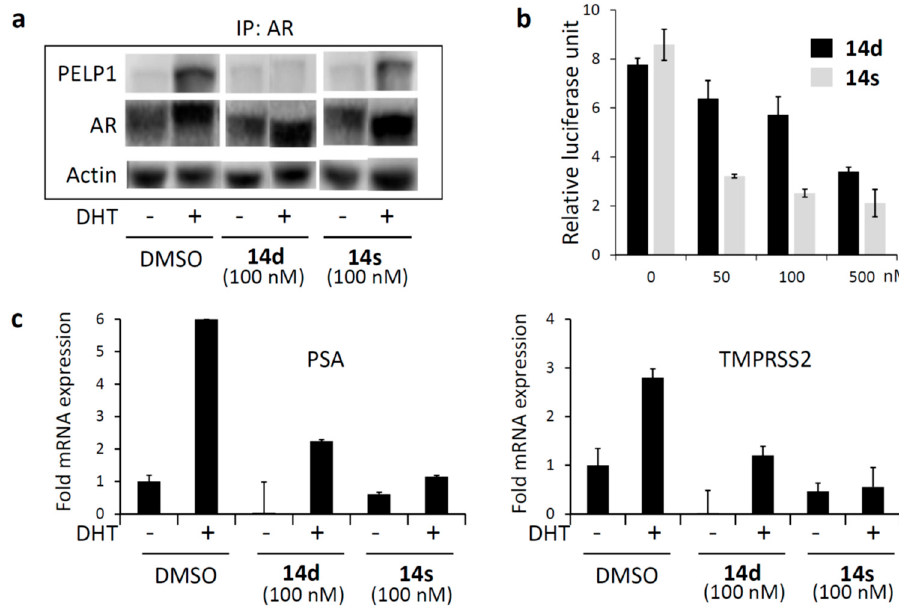
Figure 4. Inhibition of androgen receptor (AR)–coactivator interaction and AR-mediated transcriptional activity by compounds 14d and 14s . ( a ) The e ff ects of 14d and 14s on the interaction of AR with PELP1 on LNCaP cells. ( b ) The e ff ects of 14d and 14s on ARE-luciferase activity on LNCaP cells. ( c ) The e ff ects of 14d and 14s on the expression levels of AR target genes, prostate specific antigen (PSA) and TMPRSS2, in LNCaP cells.